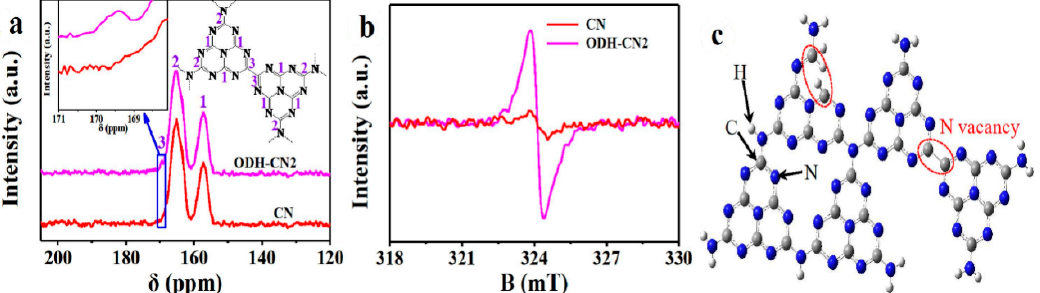
Figure 9. 13 C solid-state magic-angle spinning NMR spectra ( a ), electron paramagnetic resonance (EPR) spectra of g-C 3 N 4 (CN) and oxalyl dihydrazide (ODH)-CN2 ( b ), structure spectra of g-C 3 N 4 (CN) and oxalyl dihydrazide (ODH)-CN2 ( b ), structure model of ODH-CN with N model of ODH-CN with N vacancies ( c ). Reprinted from [133] Copyright (2020), with vacancies ( c ). Reprinted from [133] Copyright (2020), with permission from permission from Elsevier.